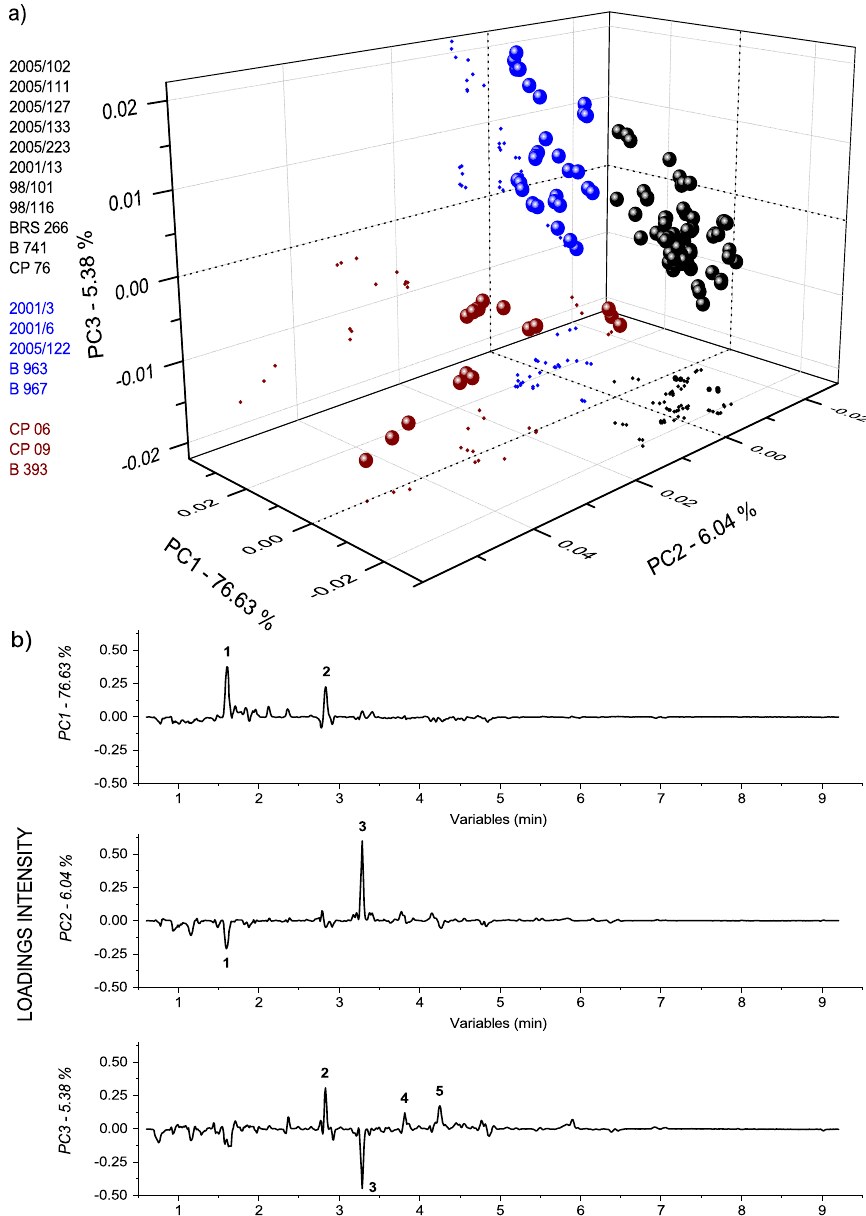
Figure 5. PLS-DA classification model of UPLC-HRMS data from cashew apple pulps of different genotypes: ( a ) LV1 × LV2 × LV3 scores 3D plot; ( b ) respective loadings potted in lines form (b) from PLS-DA for classification of the cashew apple pulps. Legend: 1-galloylhexose I (1.60 min); 2-digalloylhexoside I (2.82 min); 3-hydroxybutanoic acid ethyl ester-hexoside (3.28 min); 4-myricetin-3- O -glucoside (3.83 min); and 5-myricetin-3- O -rhamnoside (4.25 min).